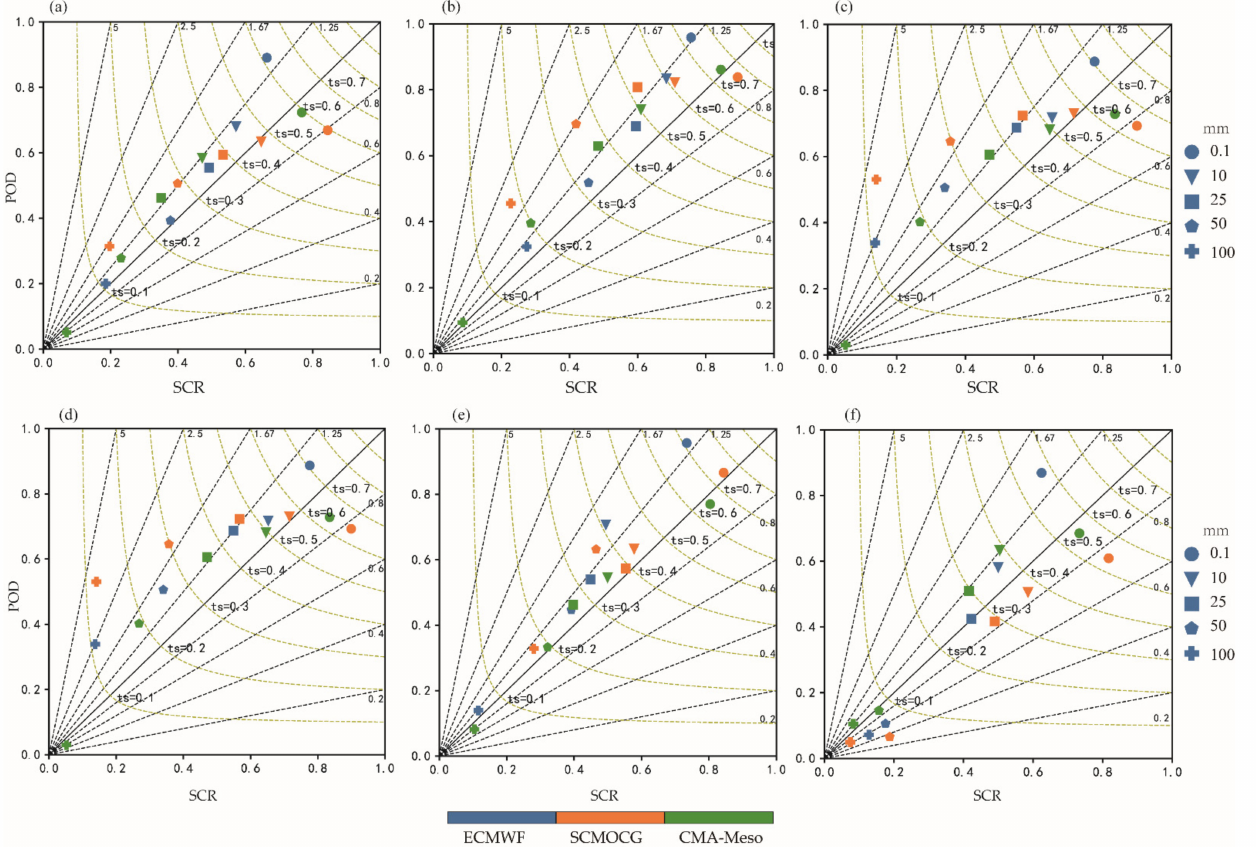
Figure 3. Comprehensive diagram of the 24 h precipitation forecast score of the three products: ( a ) all individual cases. ( b ) FGXFC. ( c ) XFC. ( d ) XNW. ( e ) DWQB. ( f ) RST. The different colors in the figure represent different precipitation products, and the different shapes represent different precipitation grades. The yellow curve in the figure is TS isoline, and the black dotted line is Bias